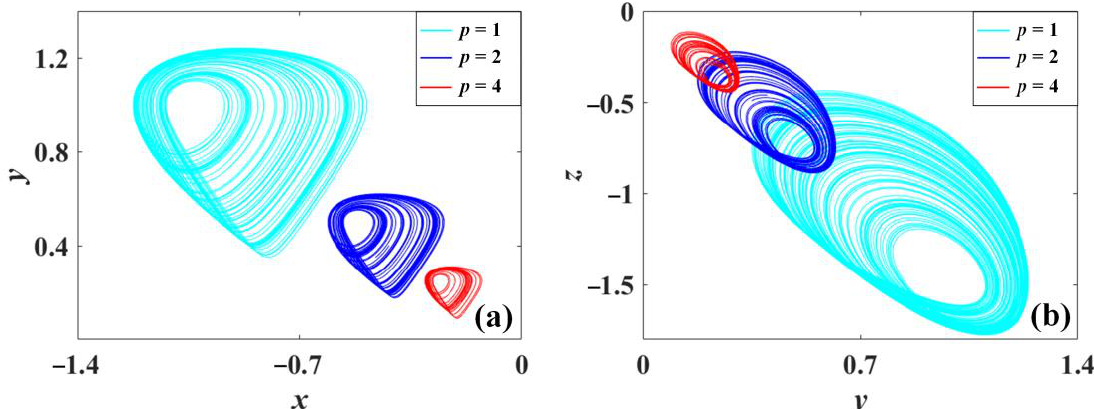
Figure 4. Chaotic oscillation of system (5) with a = 0.5, b = 0.6, and c = 1.2 under initial condition (0,